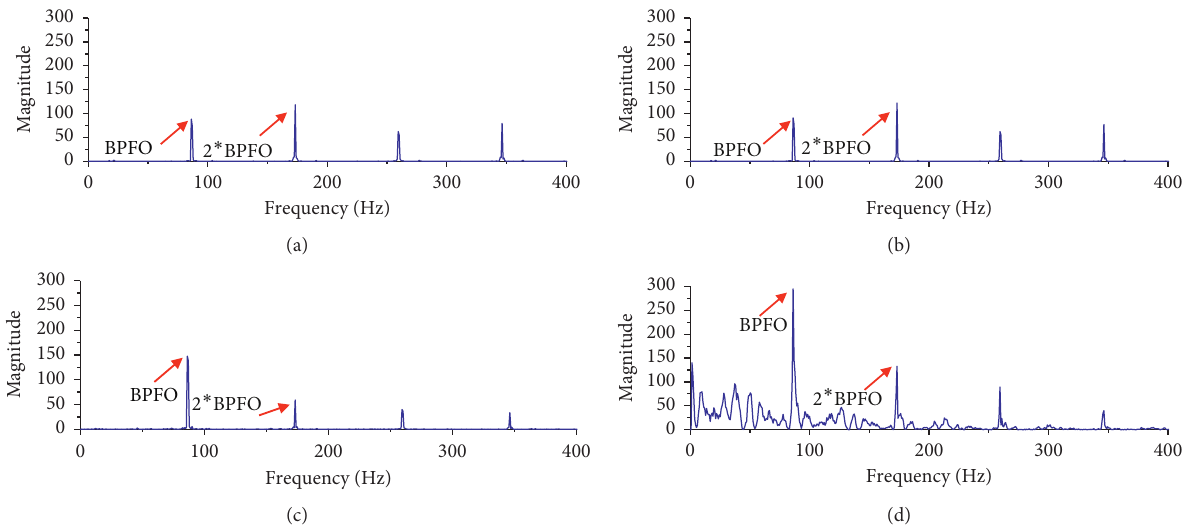
Figure 9: Processing result of the vibration signal induced by the outer race fault. (a) Envelope demodulation; (b) peak-based wavelet decomposition; (c) parameter-optimized peak-based wavelet decomposition; (d) proposed peak-based mode